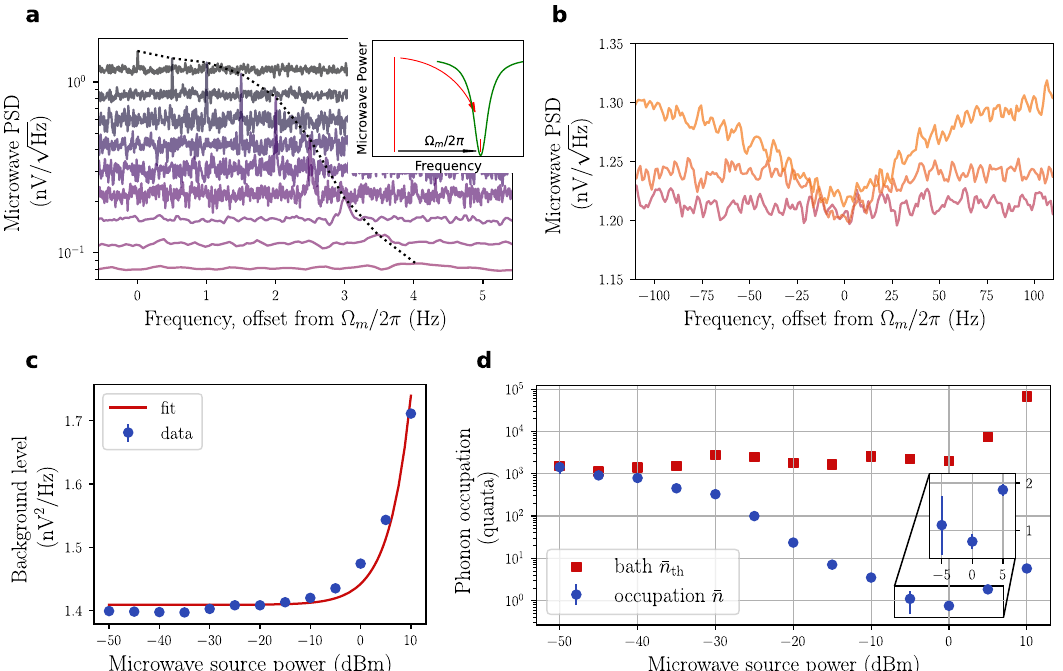
Fig. 4 Sideband cooling of the mechanics to its motional ground state. a Mechanical power spectral density (PSD) around the defect mode as the cooling power is increased: the peak fi rst increases in height with measurement gain, then visibly broadens as cooling takes place. For readability, spectra are arti fi cially offset downward and to the right in equal steps respectively as the power is increased. The dotted line is a guide to the eye for the location of the mechanical peaks. The inset depicts the scattering process due to the mechanics, which creates a sideband (small vertical red line) in the microwave cavity (green dip) at an angular frequency Ω m above the pump tone (tall vertical red line). b At high pump powers, the cavity is populated due to the microwave phase noise: the noise occupancy is visible in the ‘ squashing ’ of the mechanical feature. c The increased background level of the mechanical spectrum allows to extract the cavity occupation ~ n . d The mechanical occupation, calibrated in number of motional quanta, reaches below one phonon by dynamical backaction cooling before being heated up by cavity occupation due to input phase noise. Error bars are std. dev. of the mechanical sideband area fi